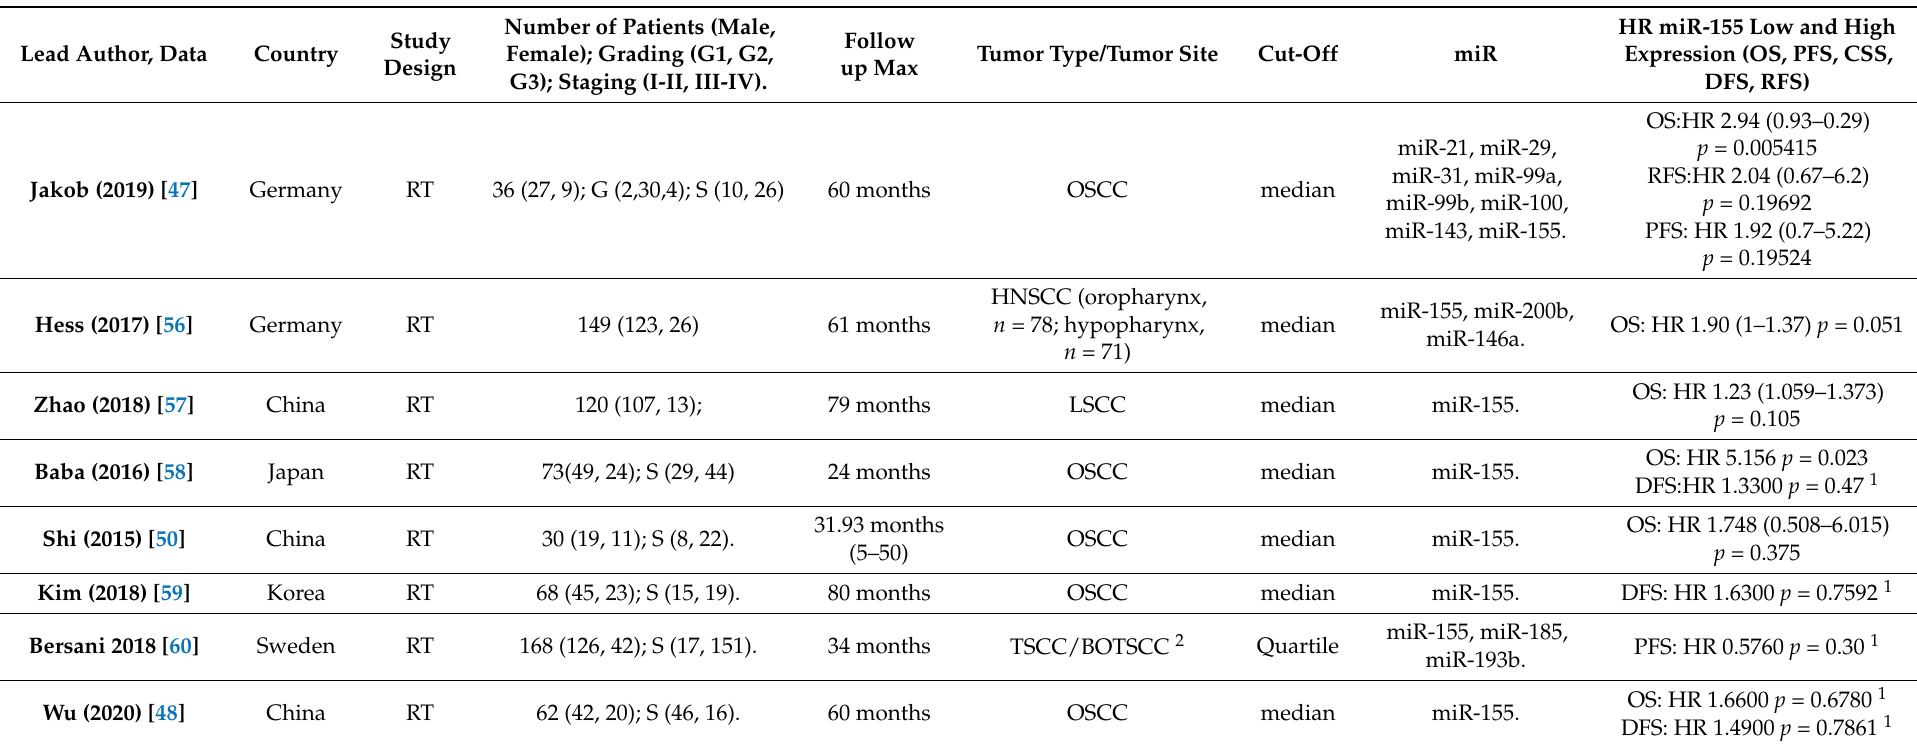
Table 1. The data extracted for the four articles included in the